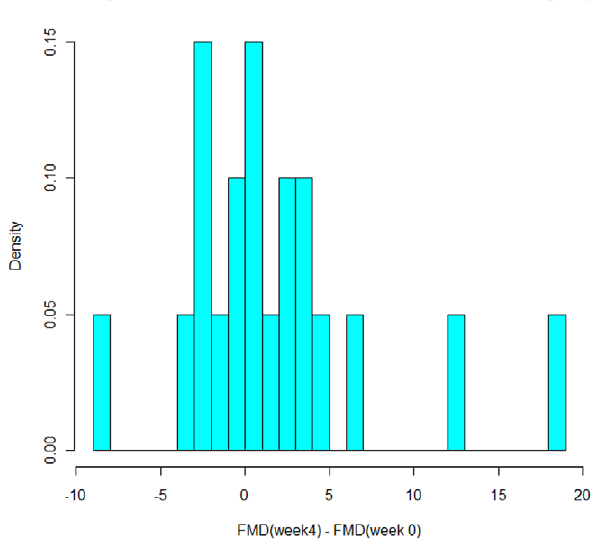
Figure 3. Histogram of the differences in FMD between week 4 and week 0 in the interventional group.